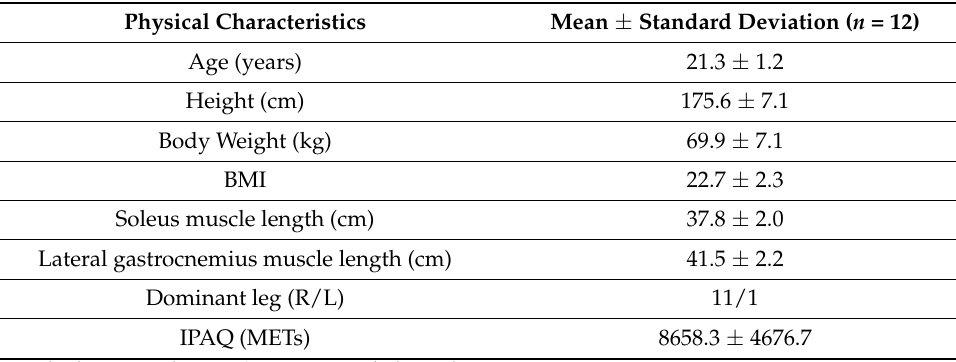
Table 1. Physical characteristics of the participants.